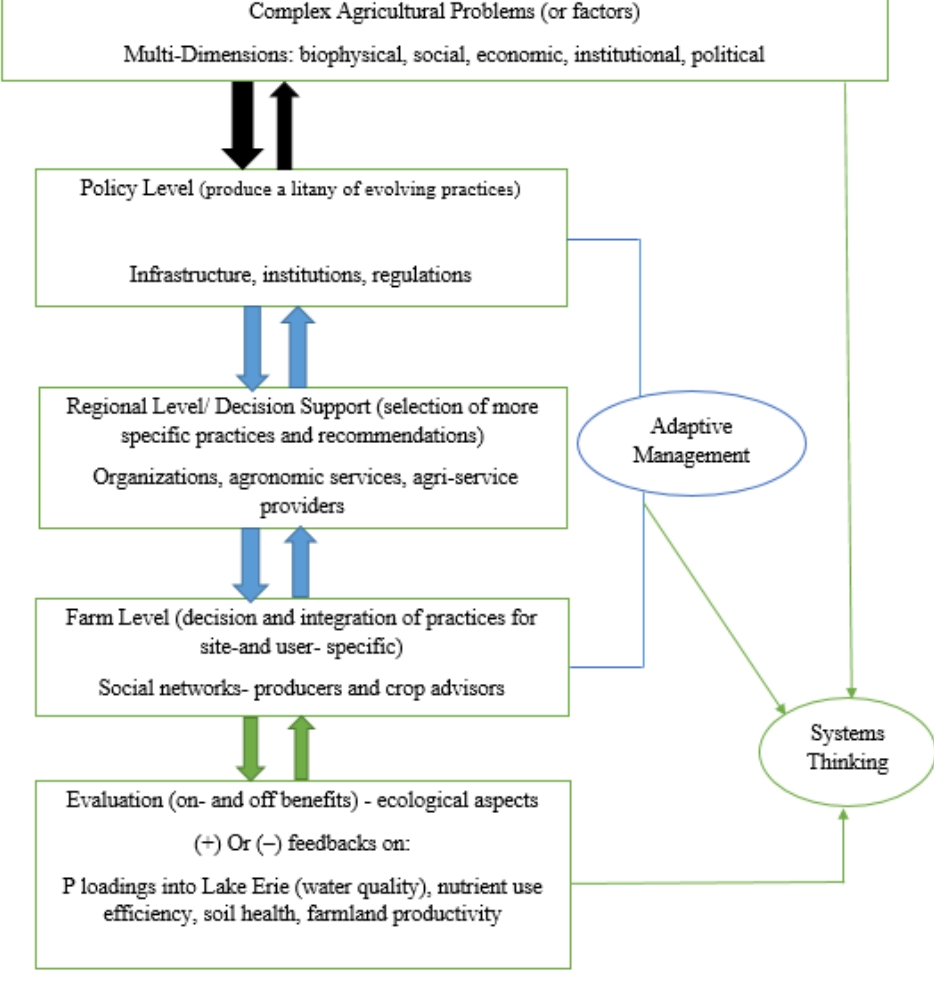
Figure 3. Adaptive management as part of systems thinking.